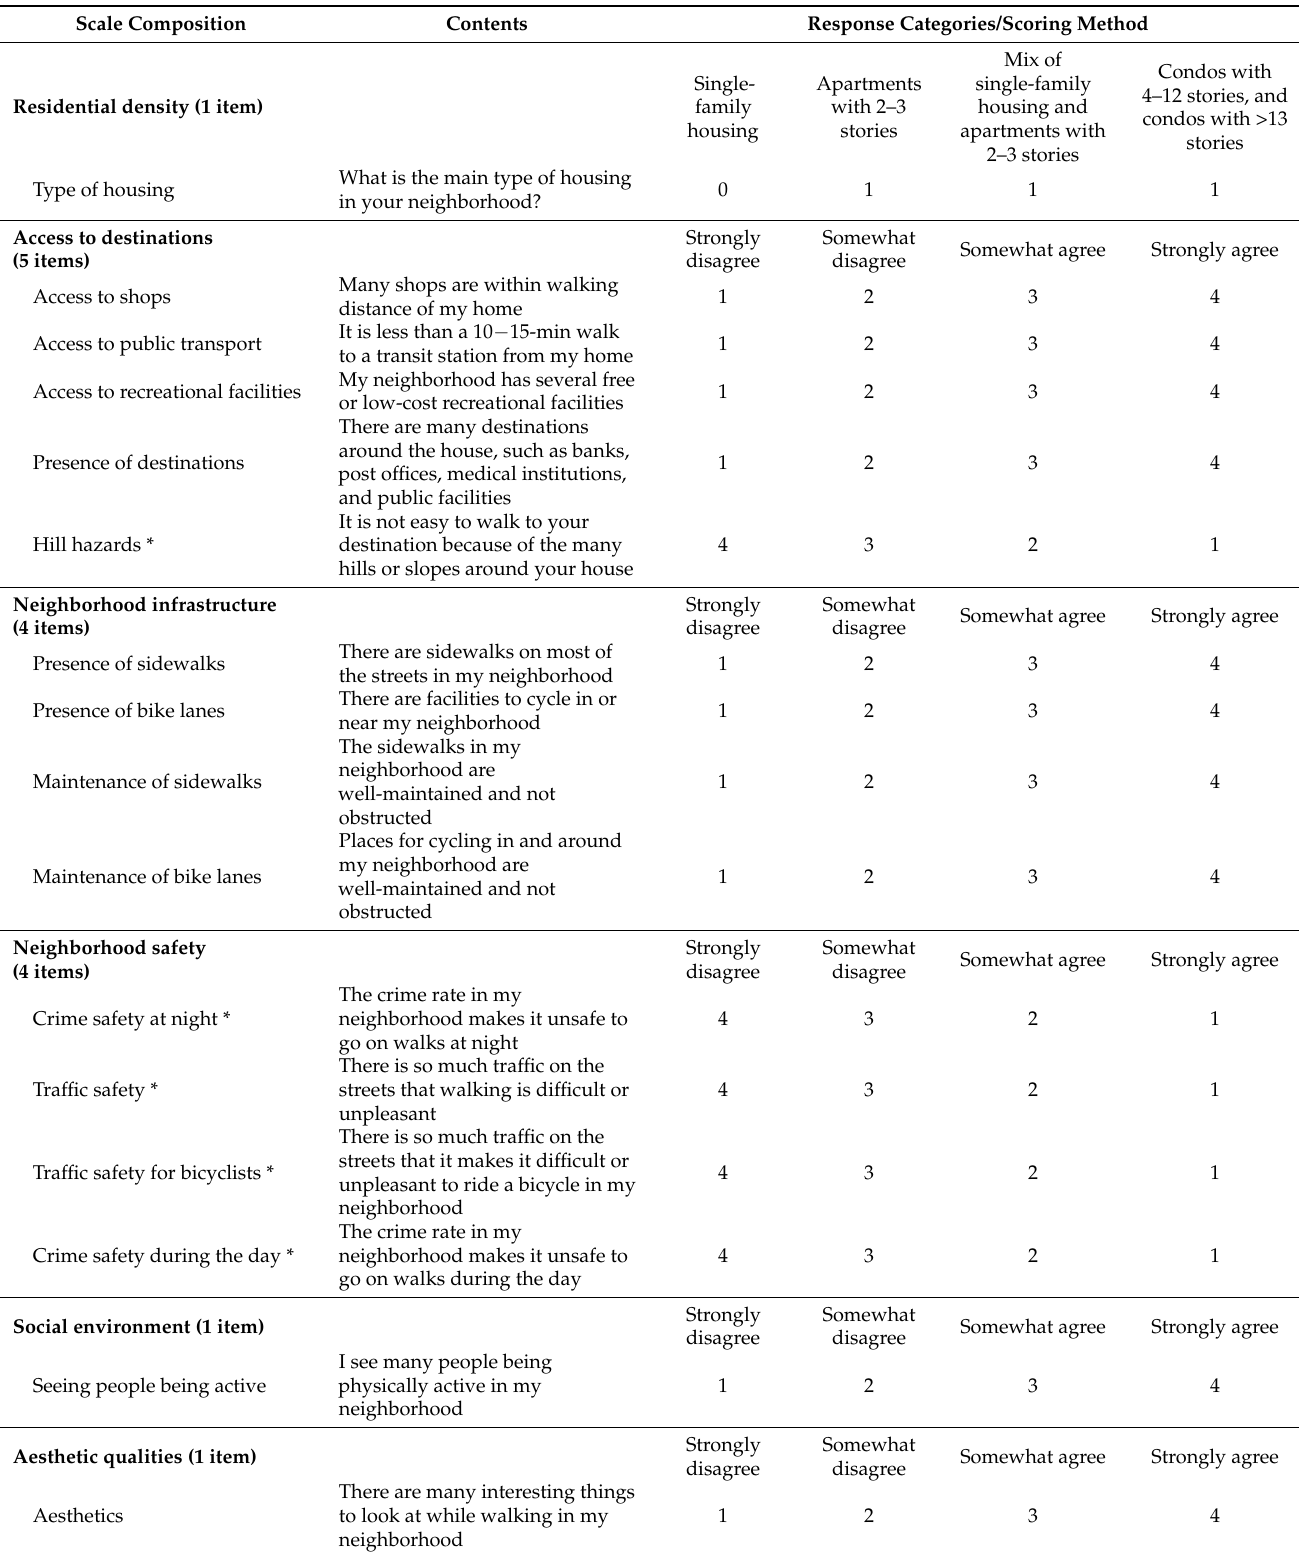
Table A1. The 17 items of the International Physical Activity Questionnaire Environmental Module and scoring